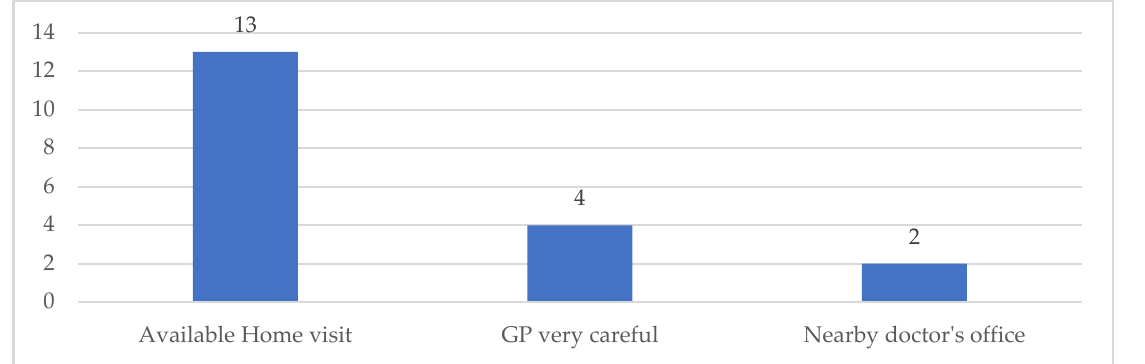
Figure 8. Reasons supporting a good relationship with GP ( n ). No reason was reported in three cases.